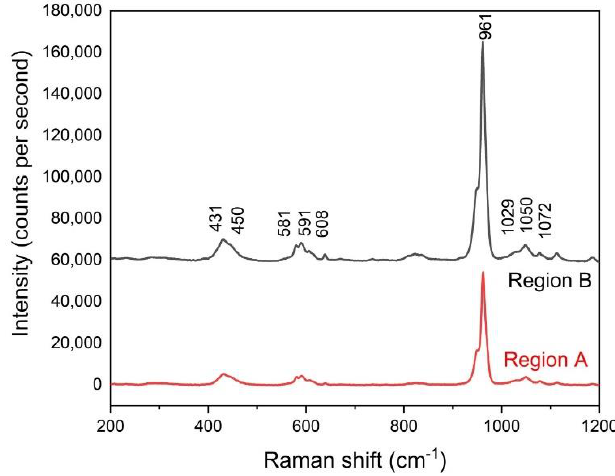
Figure 9. Raman microspectroscopy of the regions in the HAp coating.